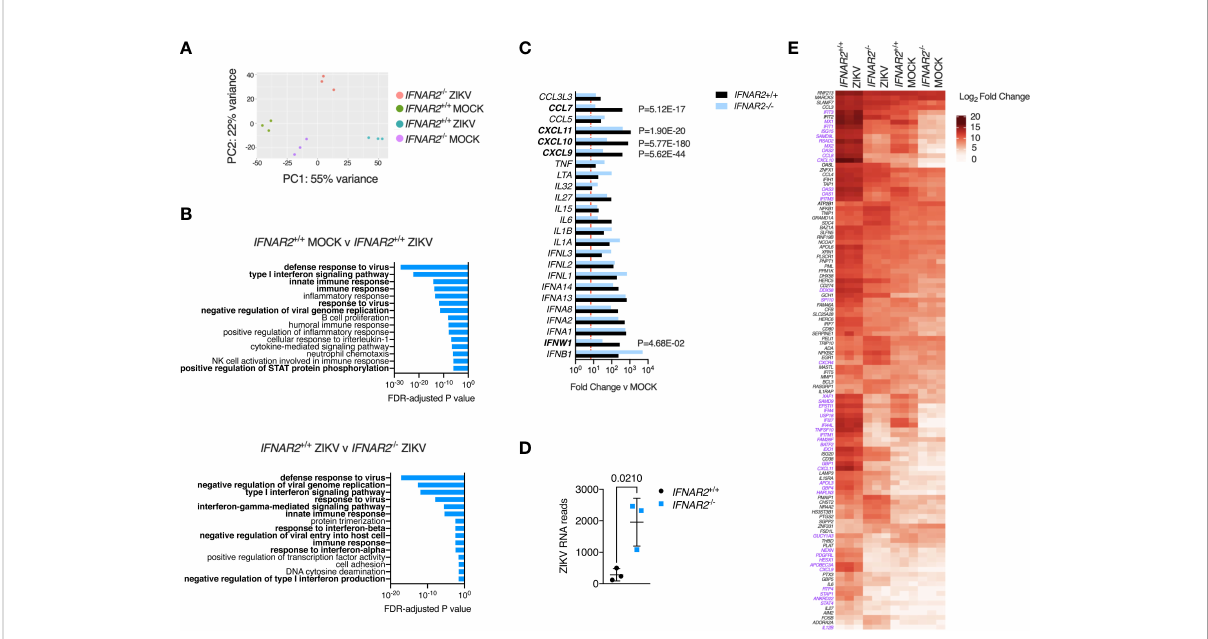
FIGURE 8 IFN-I signalling dominates the transcriptional response to ZIKV infection. (A) Principal component analysis of RNA-seq data (24 h.p.i. ZIKV FP MOI = 1.0, n=3 biological replicates in isogenic IFNAR2 -/- [B5_2] and IFNAR2 +/+ [F8] iPS-M f ). (B) Gene ontology analysis (FDR<5%) of RNA- seq data, comparing mock v infected IFNAR2 +/+ iPS-M f (top) and IFNAR2 -/- v IFNAR2 +/+ iPS-M f (bottom). Selected pathways highlighted in bold. (C) Signi fi cantly differentially expressed DE IFN, chemokine and cytokine genes, comparing mock v ZIKV exposed conditions for ≥ 3, FDR < 5%) in both genotypes IFNAR2 +/+ (black bars) or IFNAR2 -/- genotype (blue bars). Genes not reaching the DE threshold (Log 2 FC are not displayed. Red dotted line represents FC threshold (Log 2 FC ≥ 3). FDR-adjusted P values are also included for signi fi cantly DE genes (in bold) comparing IFNAR2 -/- and IFNAR2 +/+ ZIKV exposed datasets. (D) Aligned ZIKV reads from data in (A) , mean ± SD, t test. (E) Heatmap displaying expression of annotated macrophage-speci fi c ISGs. Colour intensity re fl ects Log 2 FC. Signi fi cantly DE genes (Log 2 FC ≥ 3, FDR < 5%) are shown in purple text for the comparison of IFNAR2 -/- and IFNAR2 +/+ ZIKV exposed